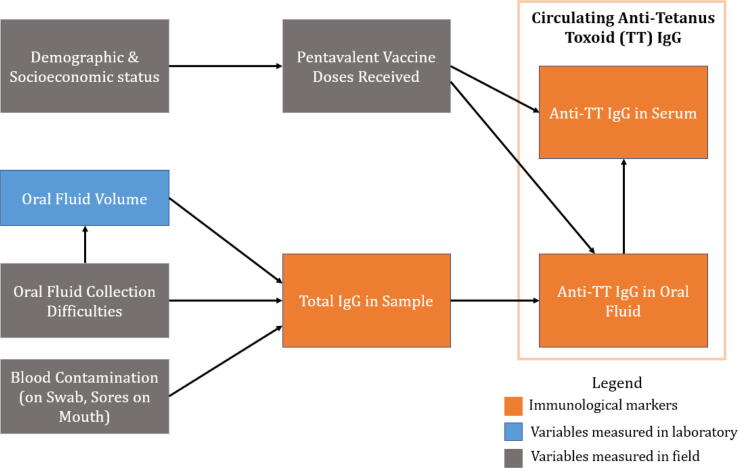
Directed acyclic graph (DAG) of risk factors contributing to poor quality oral fluid specimens and discrepancies in antibody detection between serum and oral fluid.